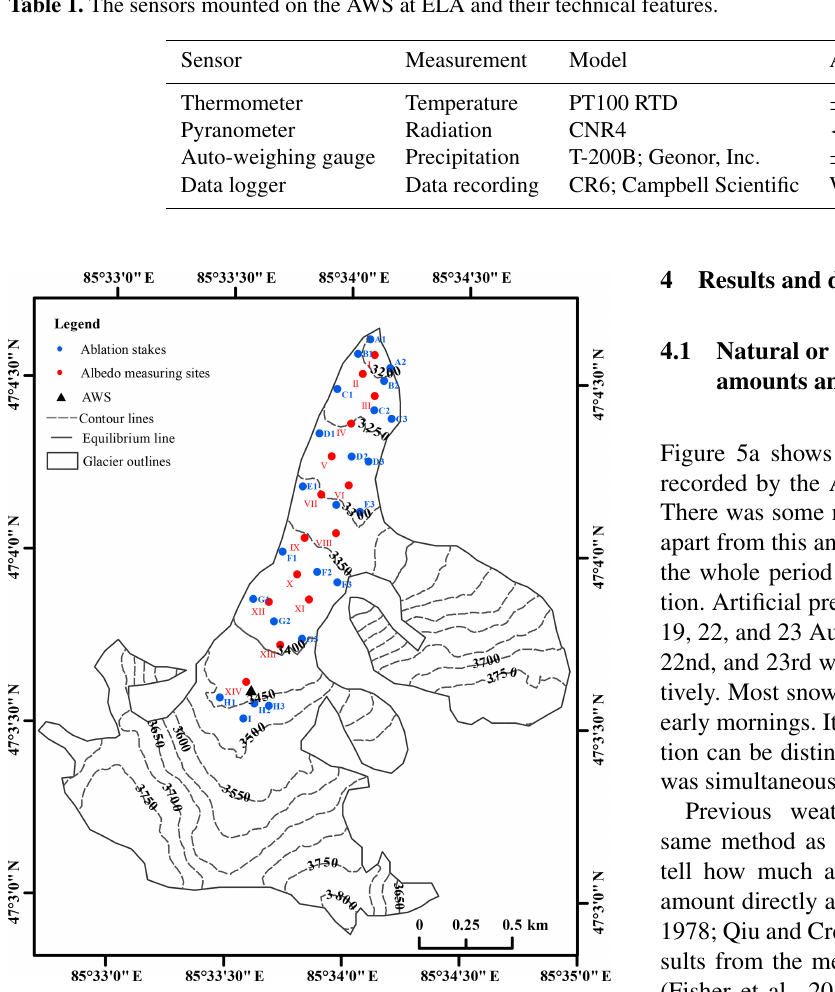
Figure 4. The location of the AWS at ELA, and the measuring sites for surface albedo and mass balance on the Muz Taw Glacier. effect of the artificial snowfalls on the mass balance of the glacier, in particular, we conducted three additional measure- ments for the mass balance on 12, 18, and 24 August 2018, respectively. The baseline of all the mass balance data in this study is the mass balance measured by the stakes on 12 Au- gust. The calculation of the mass balance of the whole glacier follows an interpolated method based on singular point mea- surements introduced by Wang et al.